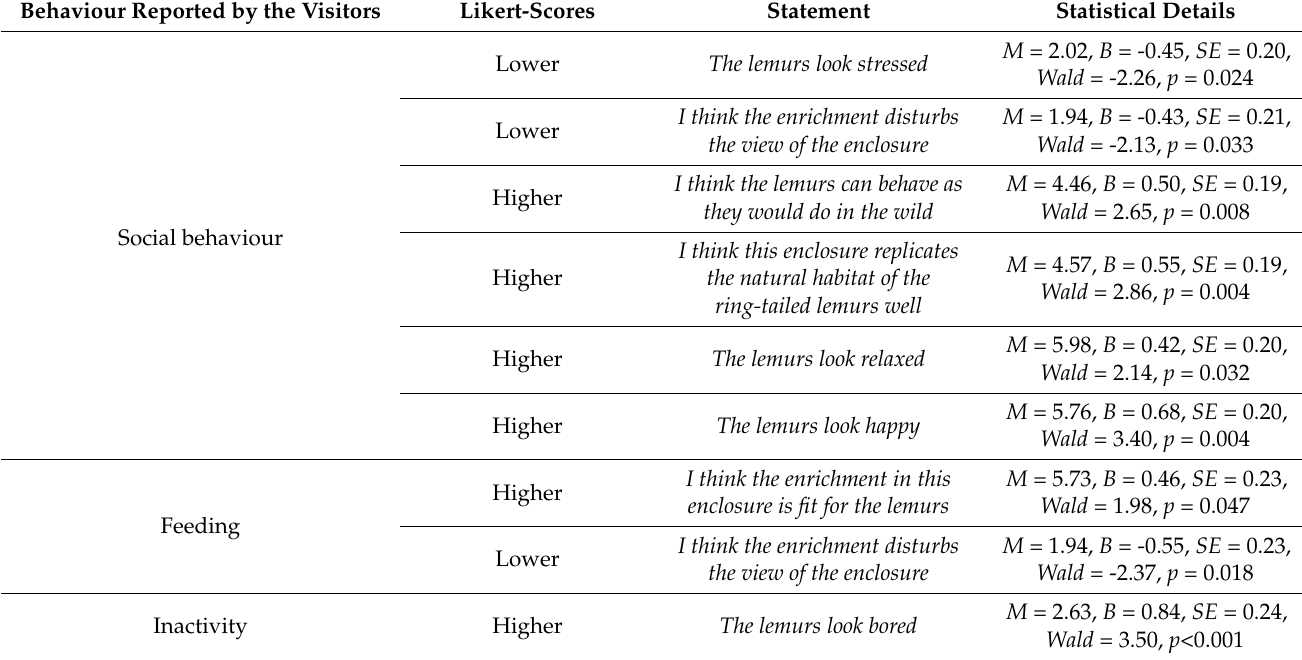
Table 5. Relationship between visitor attitudes and the lemur behaviours as observed by the researchers. Only significant results are presented. M = mean; B = regression coefficient; SE = standard error; Wald = value of the Wald test for statistical significance.